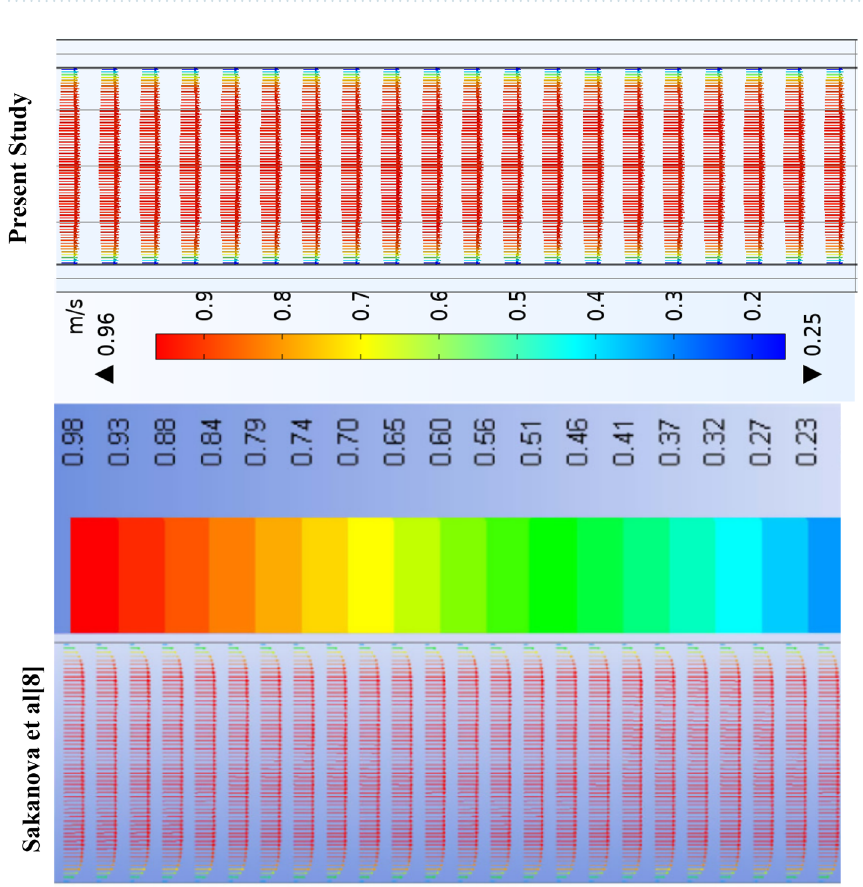
Figure 4. Code validation with Feng et al. 14 by comparsion of variation of Nusselt number ( a ) and friction factor with Reynolds number ( b ).